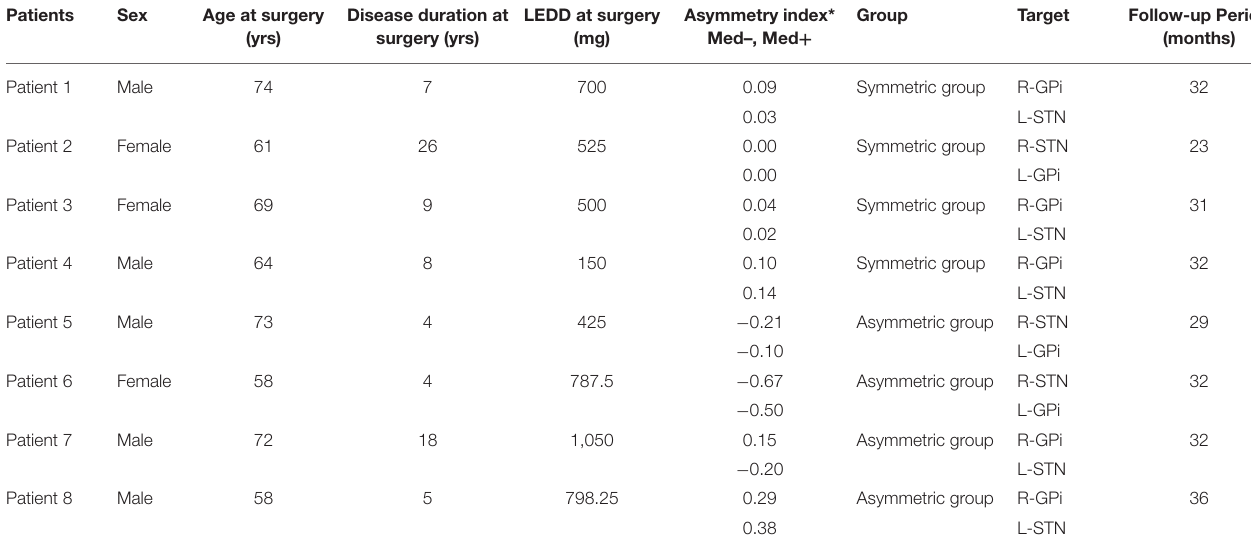
TABLE 1 | Demographic and clinical characteristics of each patient.